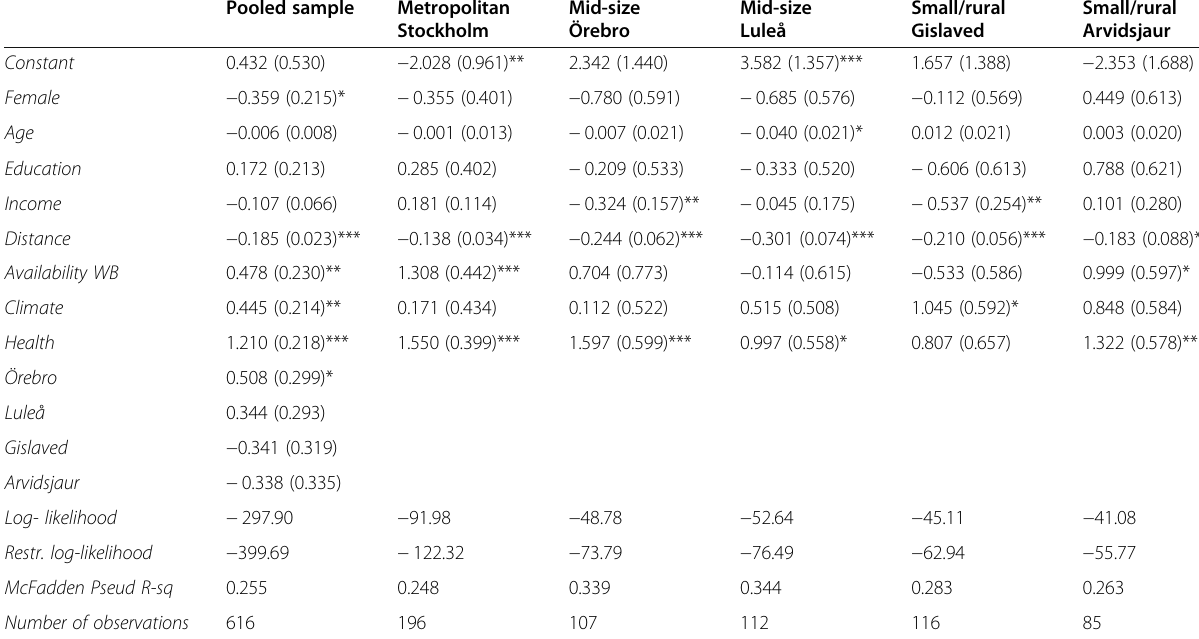
Table 5 Estimation results, binary logit models (standard errors in